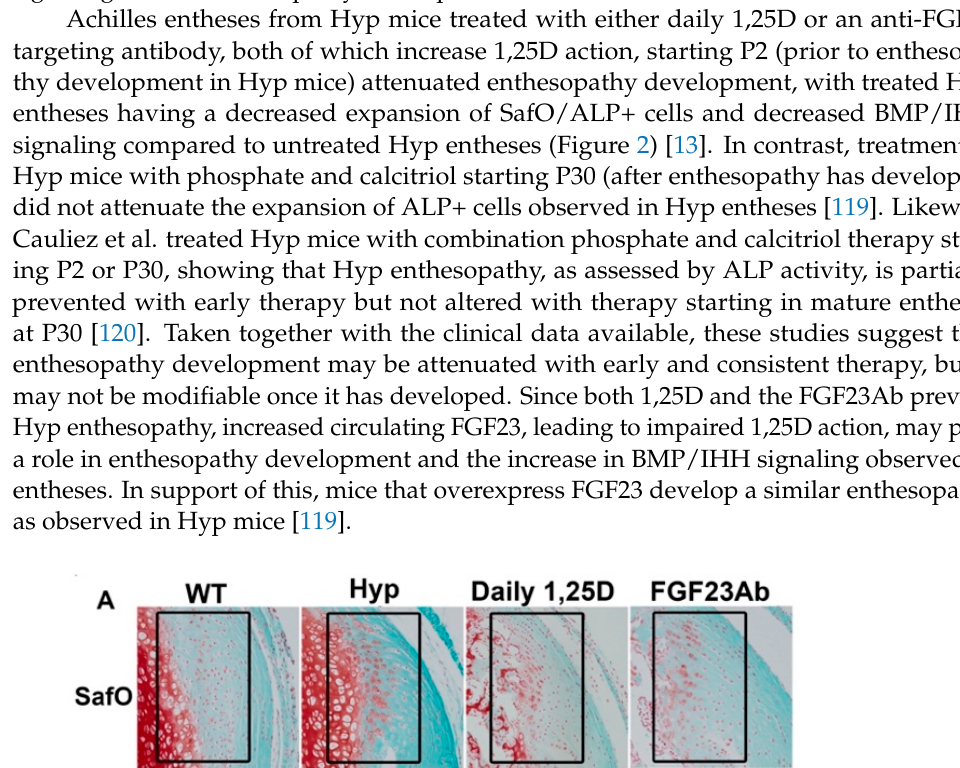
Figure 2. Treatment of Hyp mice with 1,25D or FGF23Ab starting early post-natally (P2) prevents enthesopathy: Hyp mice were treated with daily 1,25D or FGF23Ab 3x per week from post-natal day (P) 2 to P30 and Achilles entheses harvested. Hyp enthesopathy is characterized by increased bone morphogenic protein (BMP) and Indian hedgehog (IHH) signaling and alkaline phosphatase (ALP) activity in Achilles entheses, where either 1,25D or FGF23Ab treatment of Hyp mice is able to prevent development of enthesopathy. ( A ) Safranin O (SafO) stain, immunohistochemistry (IHC) for BMP marker pSmad1/5/8 and IHH signaling target Runx2 ( B ) quantification of % positive cells ( C ) ALP activity of entheses from P30 WT, control Hyp, and Hyp mice treated with 1,25D or FGF23Ab.* p < 0.05 vs. WT, # p < 0.05 vs. Hyp, a p < 0.05 vs. Daily 1,25D. All data shown were previ- ously published in [13], and there are no issues with copyright . 6. Future Directions In 2018, burosumab, a human monoclonal anti-FGF23 antibody, was approved to treat XLH in the European Union and USA. Both human and murine studies have sup- ported that the early diagnosis and initiation of therapy leads to better attenuation of XLH complications. While studies have examined the beneficial effects of burosumab on growth velocity in children and osteomalacia in adults, it remains unknown if growth and mineralization, which increase but do not normalize despite normal serum phosphate, will further improve with long-term treatment. Moreover, no data have been reported on the effectiveness of burosumab in preventing or treating enthesopathy [28,121,122]. Based on studies that 1,25D may play an important role in regulating complications of XLH such as decreased growth velocity, trabecular structure, osteocyte lacuno-canalicular remodel- ing, and enthesopathy development, it remains to be determined if the gradual decline in serum 1,25D levels during long-term burosumab treatment will have any impact on the prevention or treatment of these complications. Although burosumab has been shown to be effective in attenuating select complications of XLH, studies demonstrated that the mo- lecular mechanisms underlying these complications such as impaired mineralization and